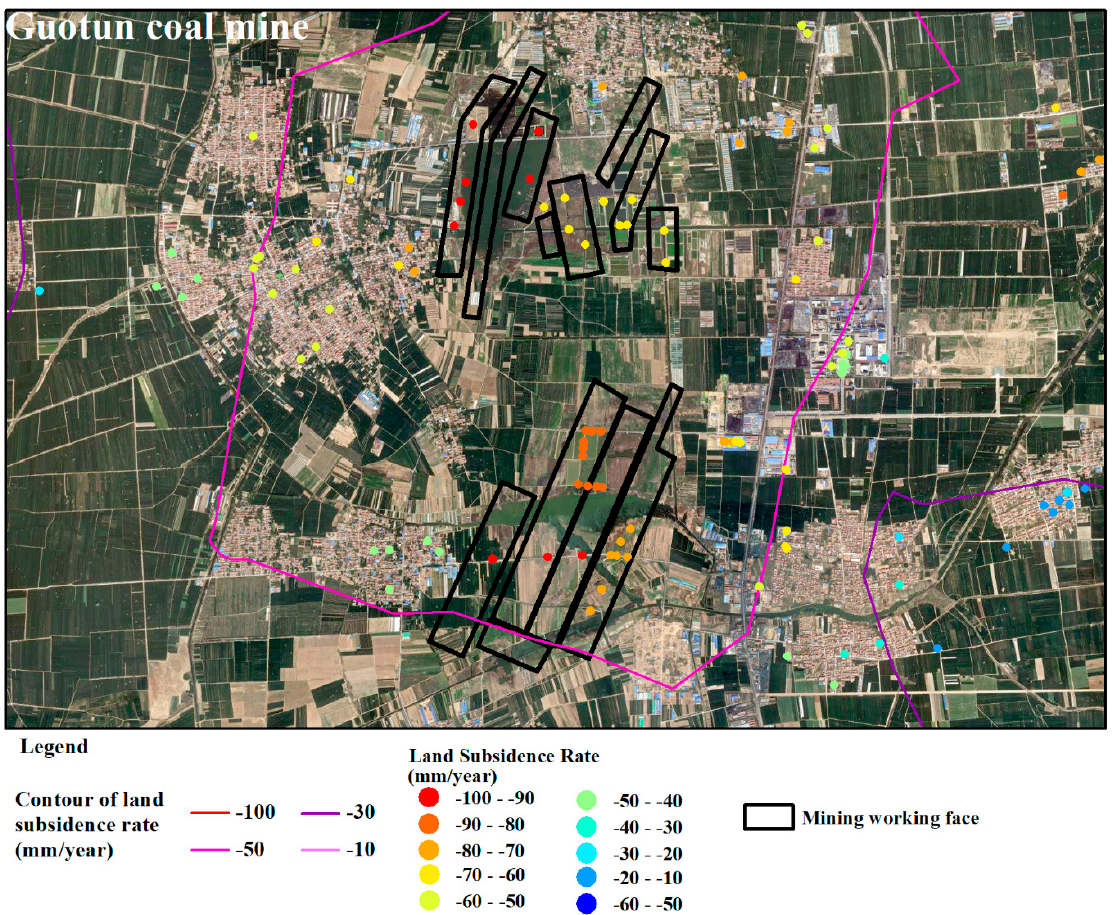
Figure 13. The average land subsidence rate of Guotun coal mine monitored by PS-InSAR.